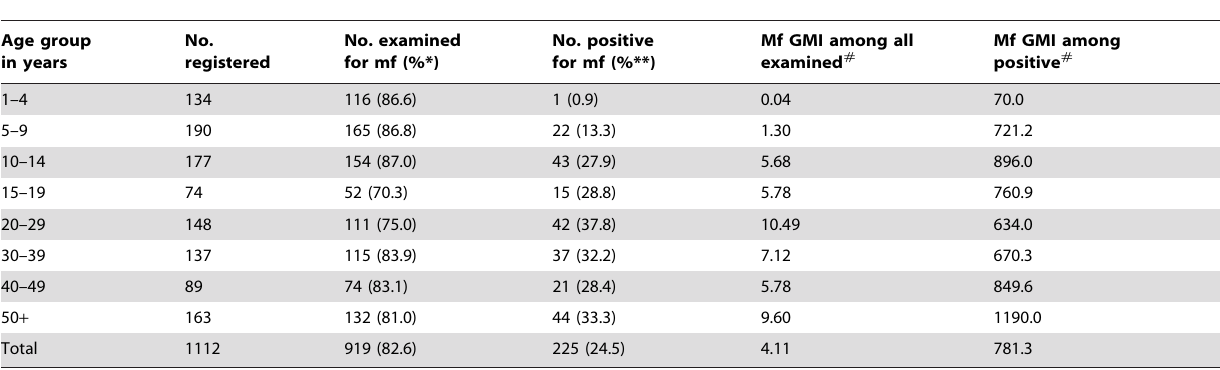
Table 1. Wuchereria bancrofti microfilaraemia in Kirare village as seen during the pre-MDA survey in September 2004.